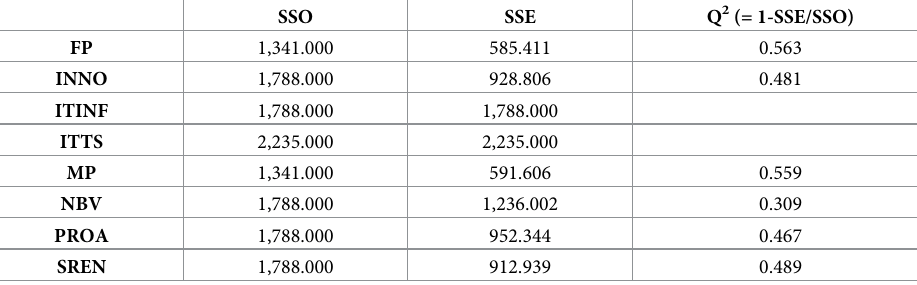
Table 8. Construct crossvalidated